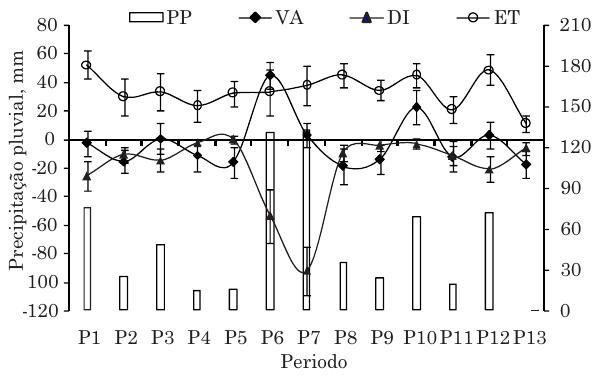
Figura 3. Valores médios da variação da armazenagem (VA), drenagem interna e ascensão capilar (DI) e evapotranspiração (ET) com os respectivos desvios-padrão e a precipitação pluvial